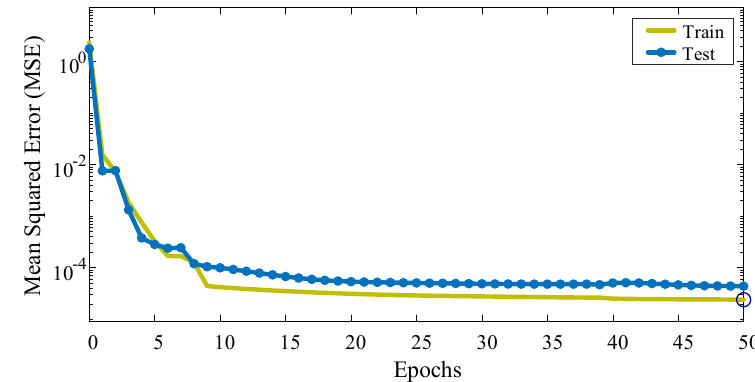
Figure 10. The two neural networks used in training: NN 1 used to approximate the relationship between the open-circuit voltage and the solar irradiance under variable temperature values, and NN 2 used to map the relationship between the irradiance and fractional open-circuit factor.